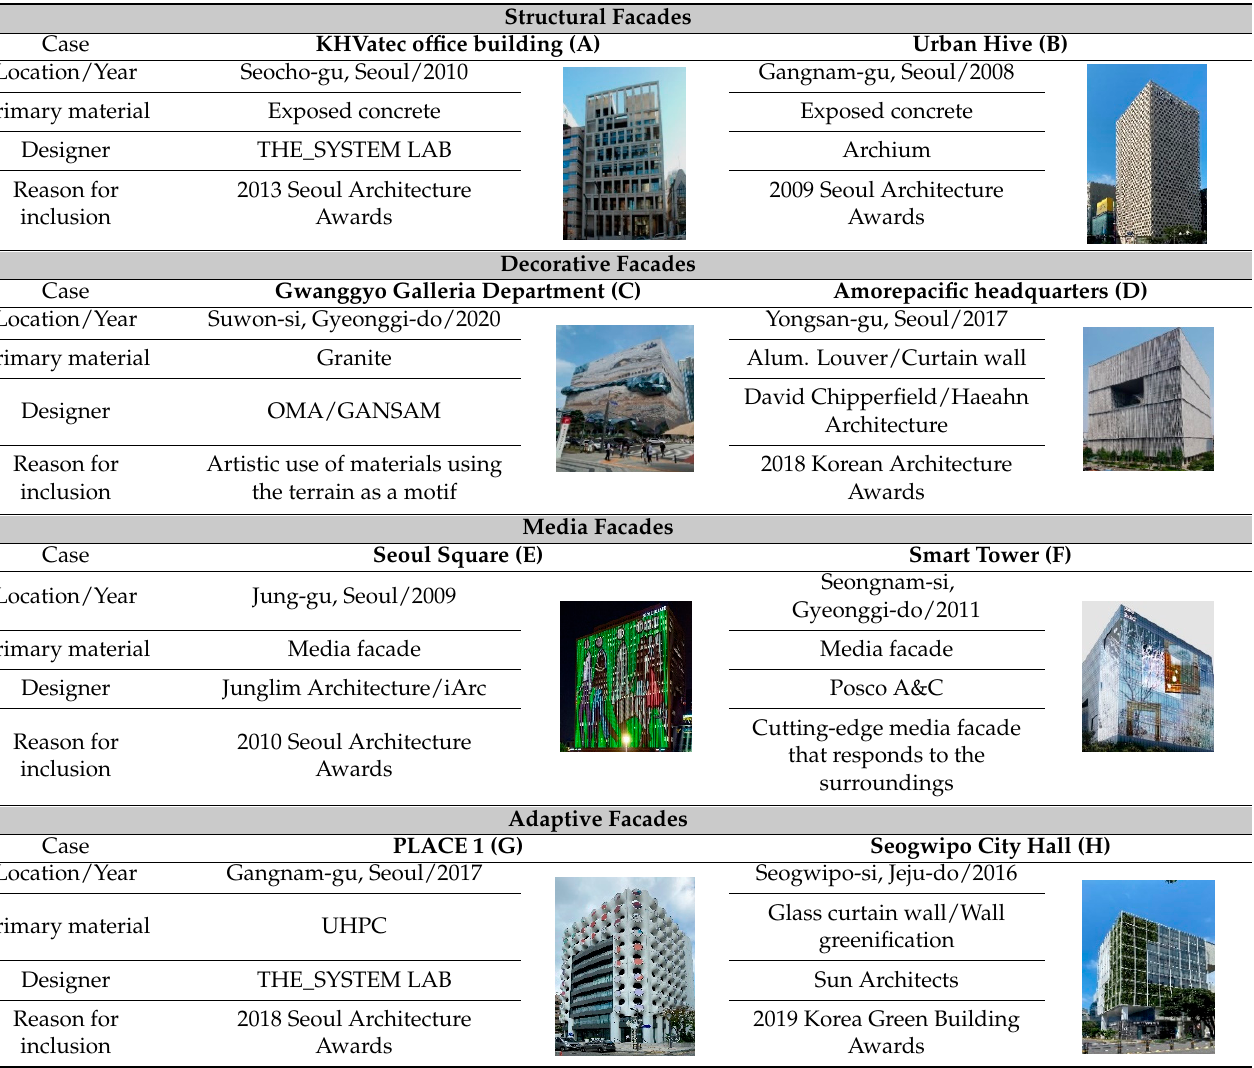
Table 1. Case studies.